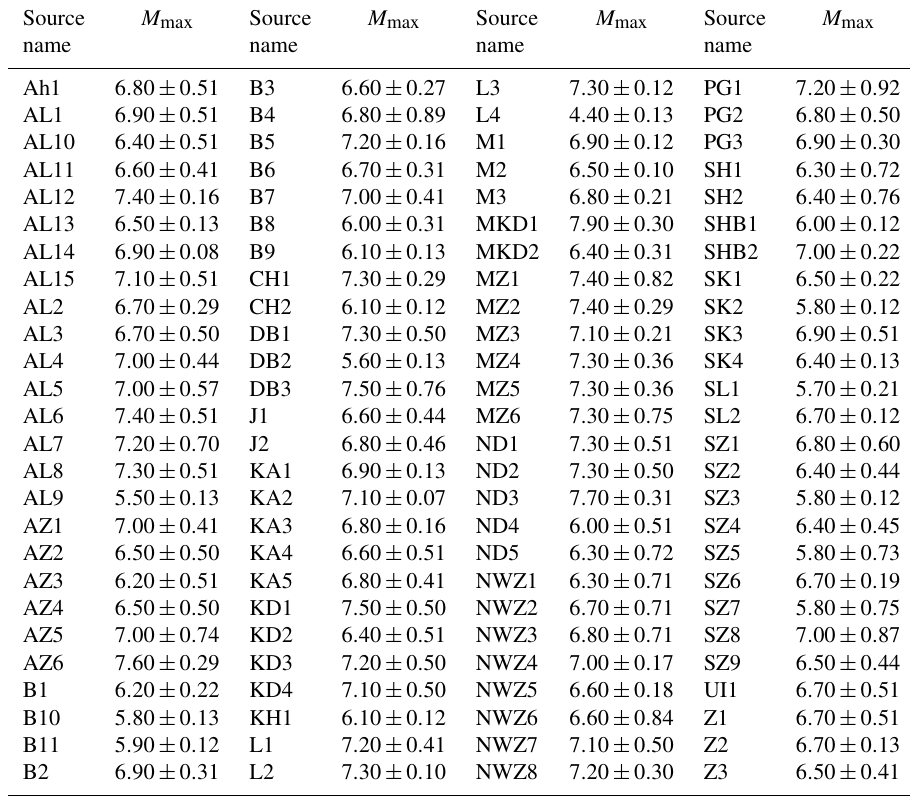
Table A1. Moment magnitude of 104 seismic regions (Karimiparidari, 2014).